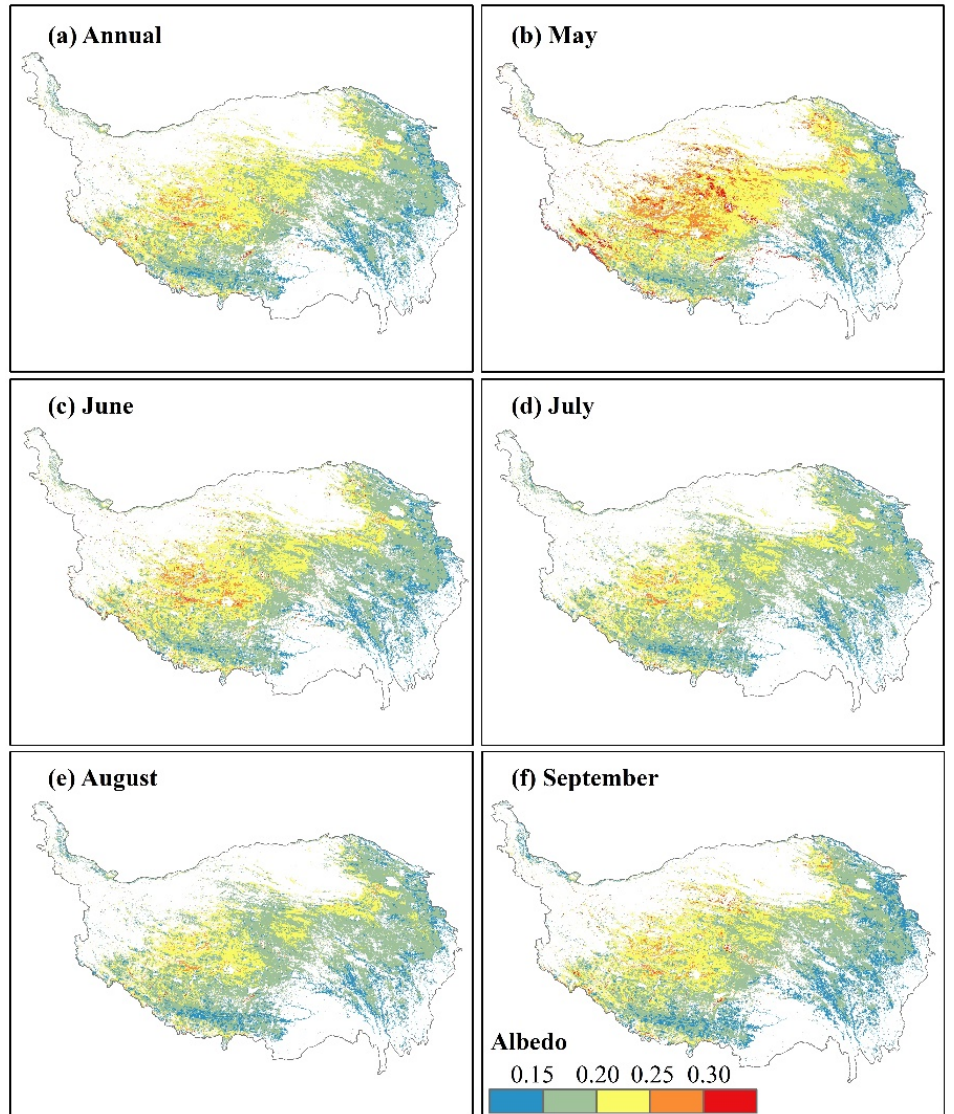
Figure 2. Spatial distributions of albedo during 2000–2016 in the growing season (annual, May, June, July, August, and September) on the QTP.